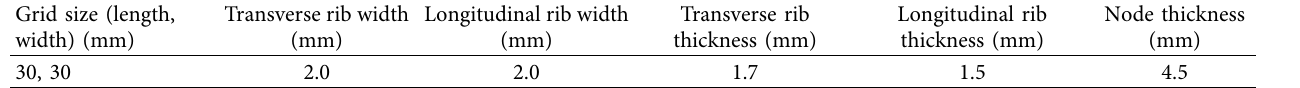
Table 2: Geogrid parameters.